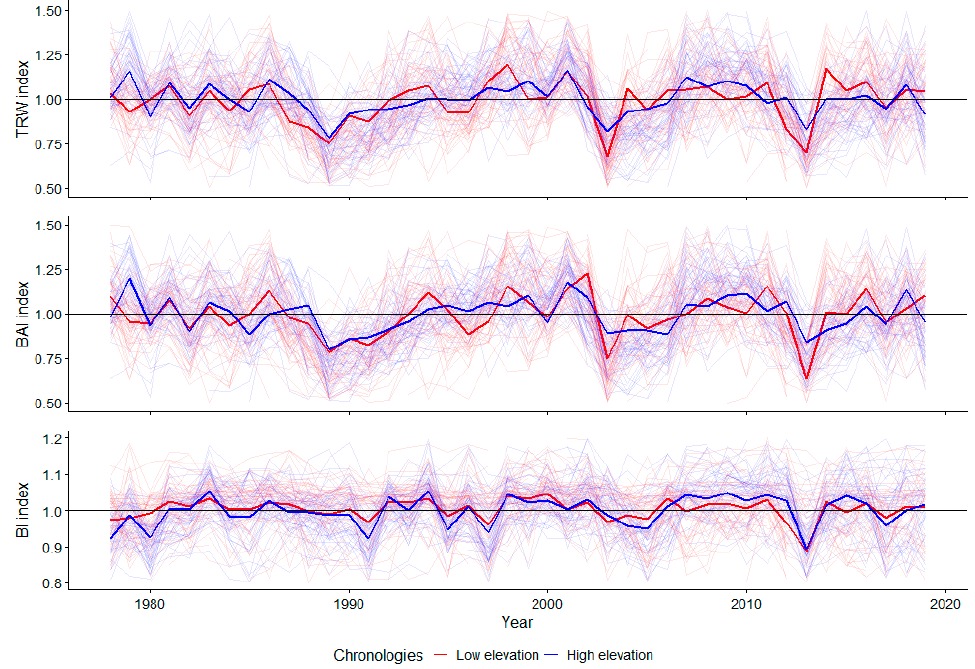
Figure 1. Norway spruce TRW, BAI, and BI residual index series chronologies for 1978–2019 (the shadowed line represents the individual series and the thicker line represents the master